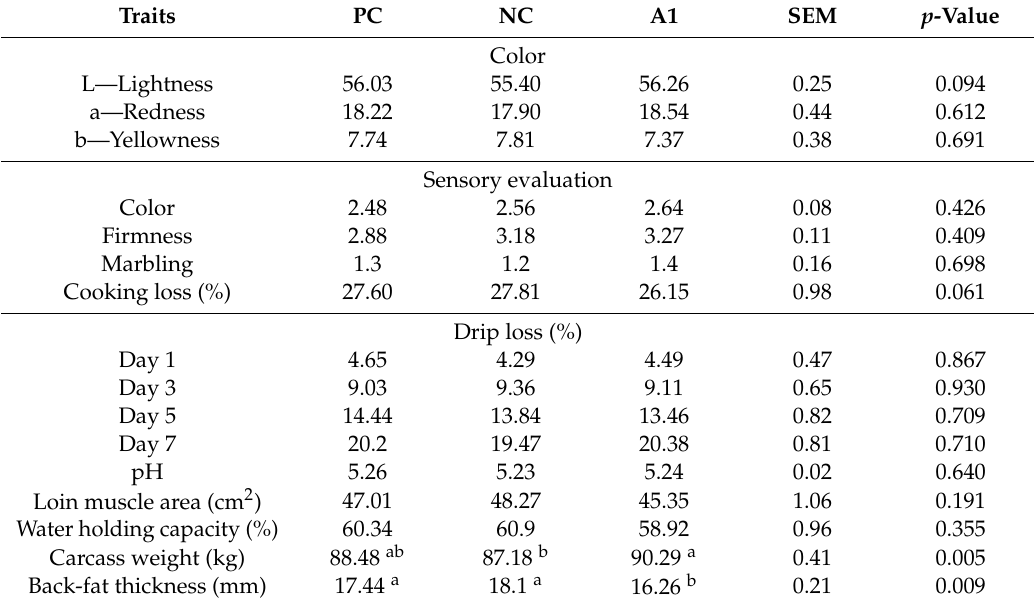
Table 5. E ff ects of dietary supplementation of enzyme blend on meat quality of grower–finisher pigs.